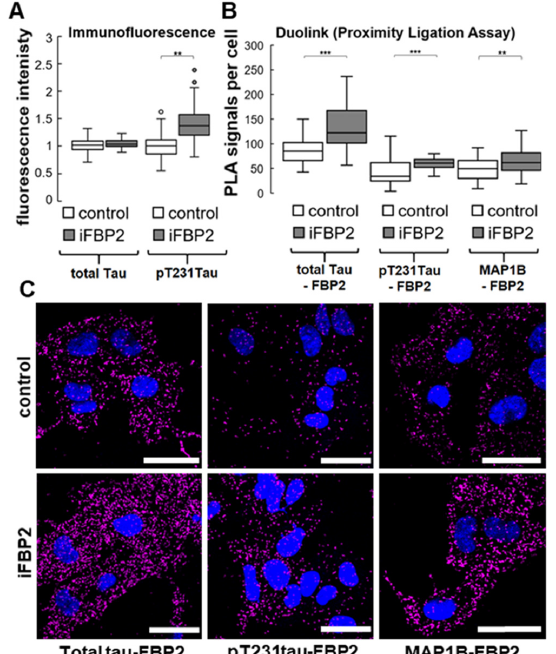
Figure 6. Wound healing assay (scratch test). Quantification of measurements of unhealed part of wounds from three time points and representative images of untreated HL-1 (control) and the FBP2 tetramerizing agent-treated cells (iFBP2) taken immediately after wounding and after 48 h of cells growth. Data are presented as mean and standard deviation. ** p < 0.01. Bar = 100 µm.